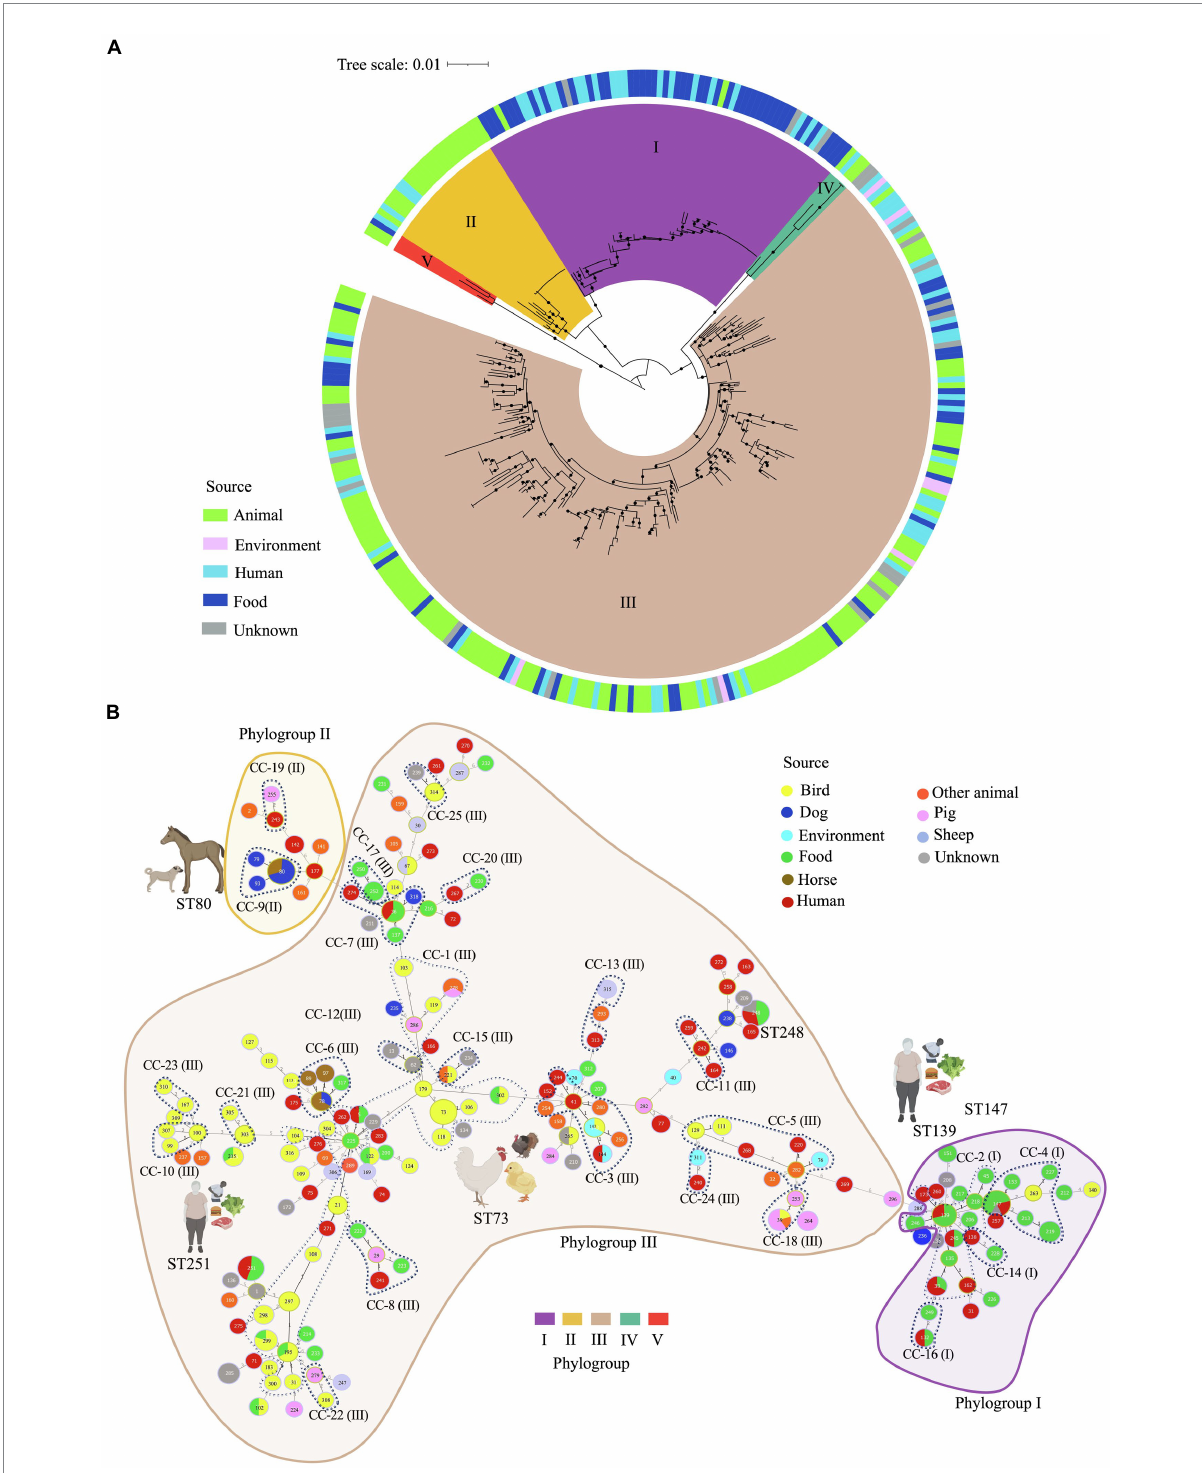
FIGURE 2 Multilocus sequence typing (MLST)-based phylogeny and goeBURST full minimum spanning tree of 195 C. perfringens MLST profiles among 322 genomes. (A) MLST-based phylogeny tree obtained with fastMLST. The outer ring shows the origin of the isolates as indicated in the legend. Clusters are represented by different colors on the inside of the ring. (B) MLST-based minimum spanning tree obtained with goe BURST. Sequence types (STs) are displayed as circles. Founder STs were defined as the STs with the greatest number of single-locus variants. Circle size indicates the number of isolates in every particular ST, with each color representing a different source type. Lines represent closely related isolates and line length illustrates STs that vary by one, two, or more alleles in their MLST profile. Clonal complexes (CC), defined as closely related STs that differ up to two of the eight loci used in the MLST scheme from a common founder (DLV, double locus variant), are designated by dashing